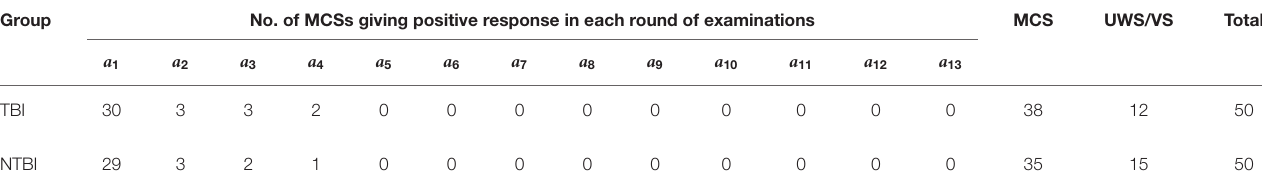
TABLE 3 | The data collected from the 13 rounds of successive examinations. Group No. of MCSs giving positive response in each round of examinations